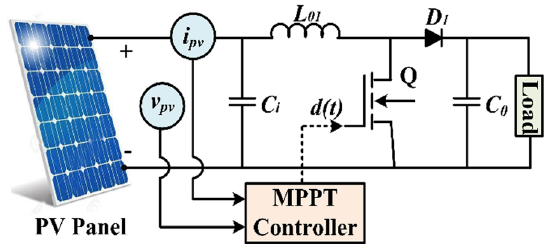
Fig. 4 PV boost converter system with MPPT controller